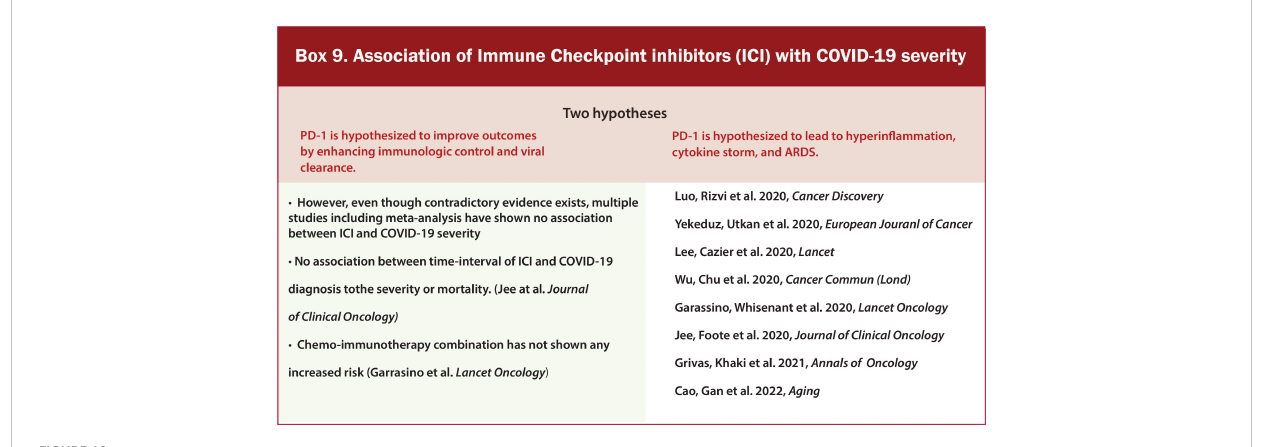
FIGURE 10 Box-9 Association of Immune Checkpoint Inhibitors (ICI) with COVID-19